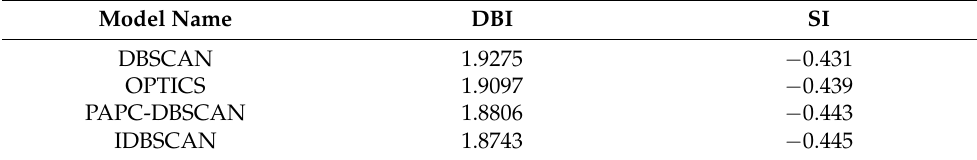
Table 4. Comparison of clustering